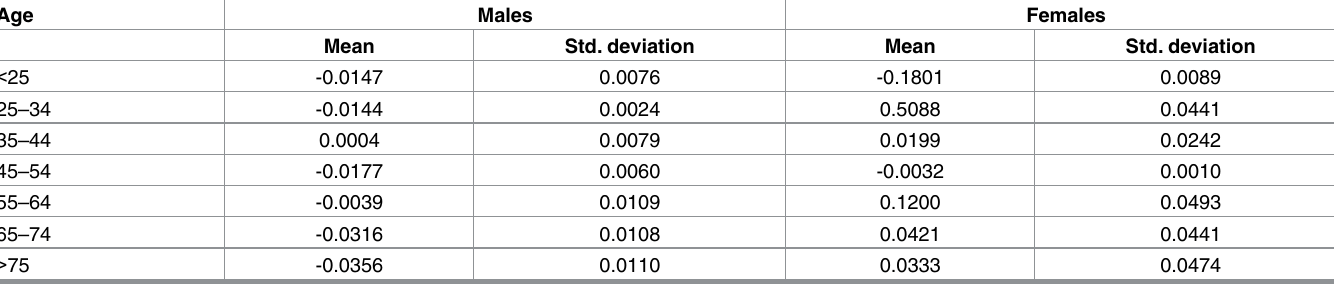
Table 2. Smoking initiation and cessation rates for the base year